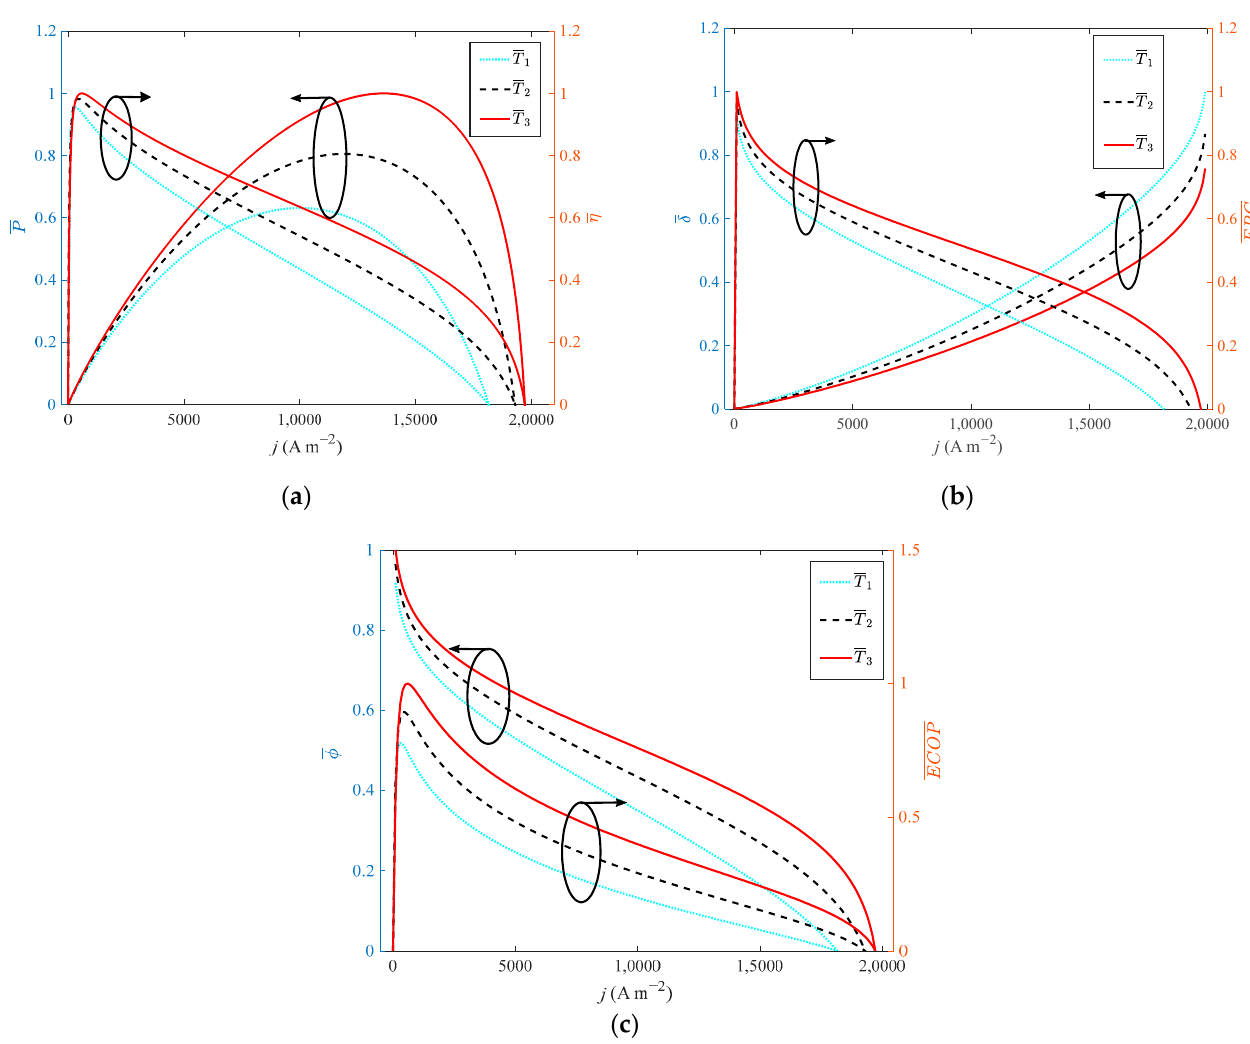
Figure 3. Different indexes vary with current density at different operating temperatures: ( a ) P and η ; ( b ) δ and EPC ; ( c ) φ and ECOP .